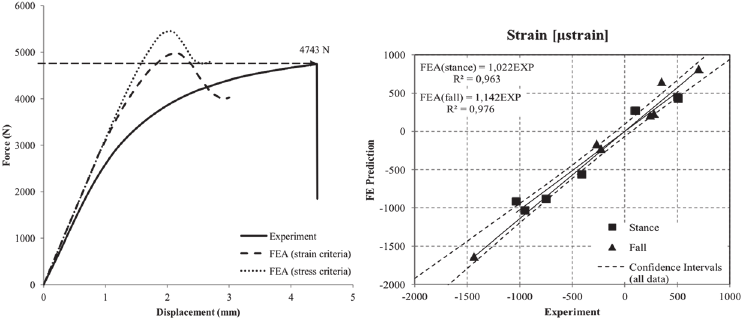
Fig 4. Left side: Load-displacement curves from the experimental data (failure load: 4743 N) as well as simulated forces extracted from the FEA models for both stress and strain criteria. Right side: Plotted FEA based predicted strains in both stance and fall configuration compared to experimentally measured